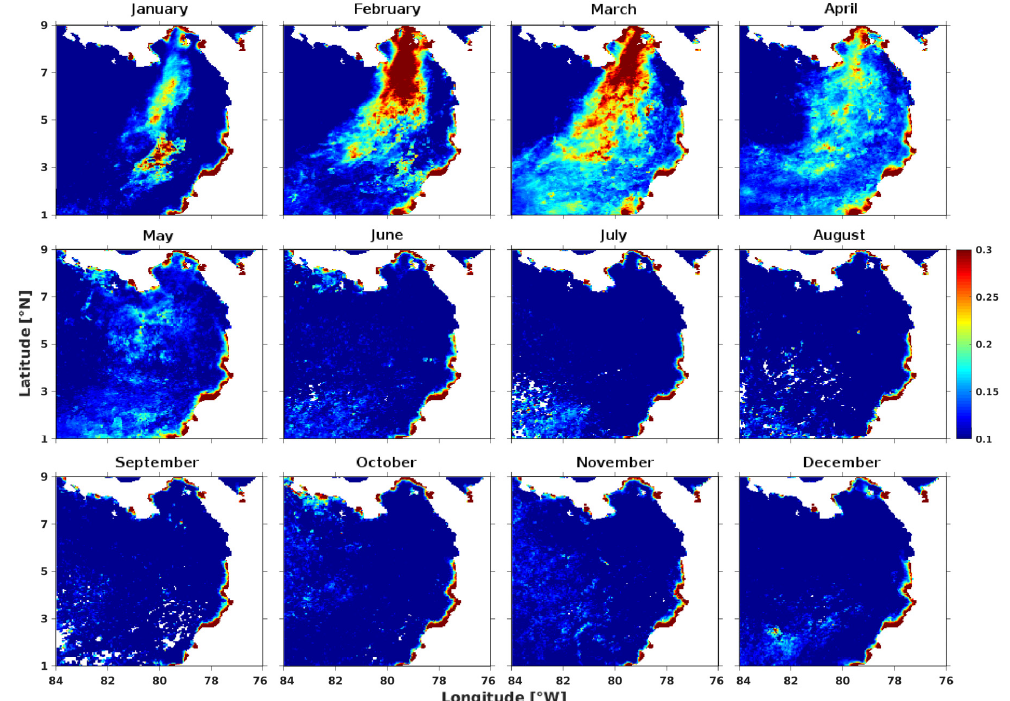
Figure A2. Monthly mean climatology of normalized fluorescence line height (nFLH; mW cm -2 μ m -1 sr -1 ), measuring phytoplankton fluorescence activity in the Panama Bight for the period of January 2002 to December 2016. Higher phytoplankton fluorescence values are represented by red color.